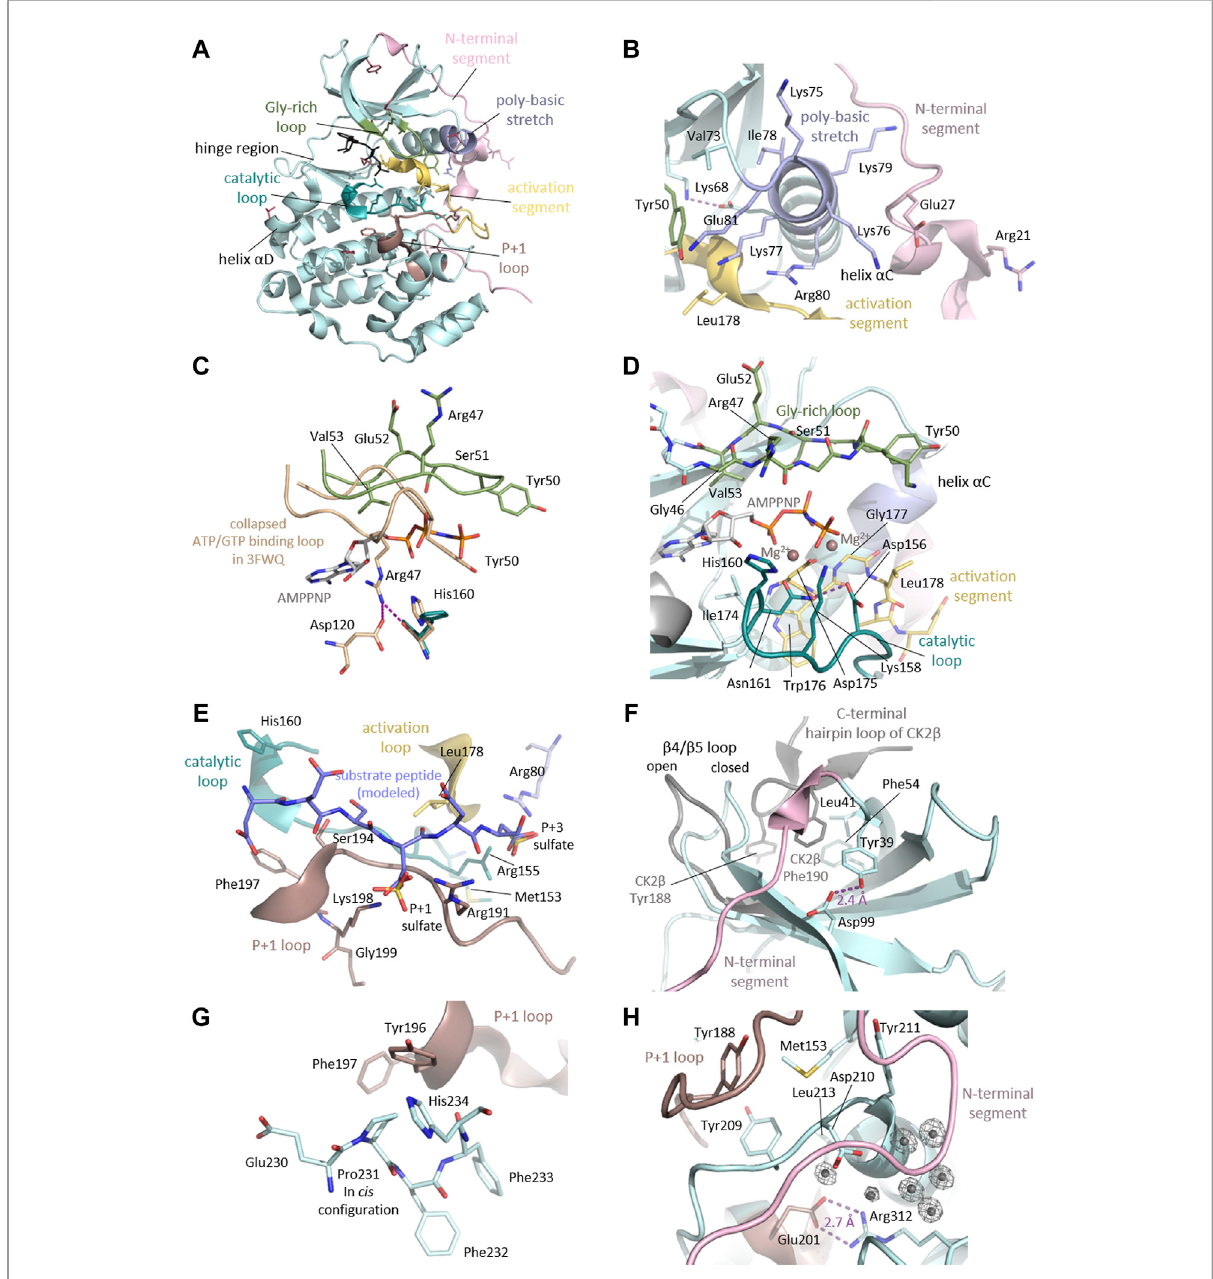
FIGURE 6 Detailed CK2 α functional and structural domains. (A) Clustering of mutation sites in the catalytic and structural key elements of CK2 α . The side chainsofthemutatedresiduesareshownassticksandarecolouredaccordingtothedifferentelementsasdescribedinthe fi gure.Mutationsitesnot residing in these elements are highlighted in raspberry red. The CK2 α 1-335 structure in complex with AMPPNP (PDB_ID: 2PVR (Nie fi nd et al., 2007)) was used for the fi gure. (B) Mutation sites in the N-terminal segment and the helix α C. The N-terminal region of CK2 α with the mutation sites Arg21 and Glu27 drawn in light pink. The helix α C, which is located adjacent to mutation site Val73, harbors the basic cluster (light blue) including the mutation site Arg80. The critical salt bridge between Lys68 and Glu81 is shown as well as the mutation sites residing in proximity such as Tyr50 from theGly-richloop(palegreen)andLeu178oftheactivation loop(yellow).TheCK2 α 1-335 structurePDB_ID:2PVR(Nie fi ndetal.,2007)wasusedforthe fi gure. (C) Mutation sites in the Gly-rich loop. The Gly-rich loop is shown in its open conformation (pale green, PDB_ID: 2PVR (Nie fi nd et al., 2007)) and collapsed conformation (wheat, PDB_ID: 3FWQ (Raaf et al., 2009). The mutation sites of the Gly-rich loop Arg47, Tyr50, Ser51, Glu52 and Val53areshownassticks,aswellasAMPPNP.Inthecollapsedconformation,Arg47formshydrogenbondstoAsp120andHis160,whicharedepicted as purple dashed lines. (D) Mutation sites in the active site of CK2 α . The mutation sites in the catalytic loop (Asp156, Lys158, His160 and Asn161) are drawnasdarkcyansticks.Theactivationloopisshownasstickrepresentation,therespectivemutationsitesareGly177andLeu178.TheGly-richloop is drawn as sticks and the mutation sites Arg47, Tyr50, Ser51, Glu52 and Val53 are labelled. Magnesium ions are shown as dark salmon spheres. The